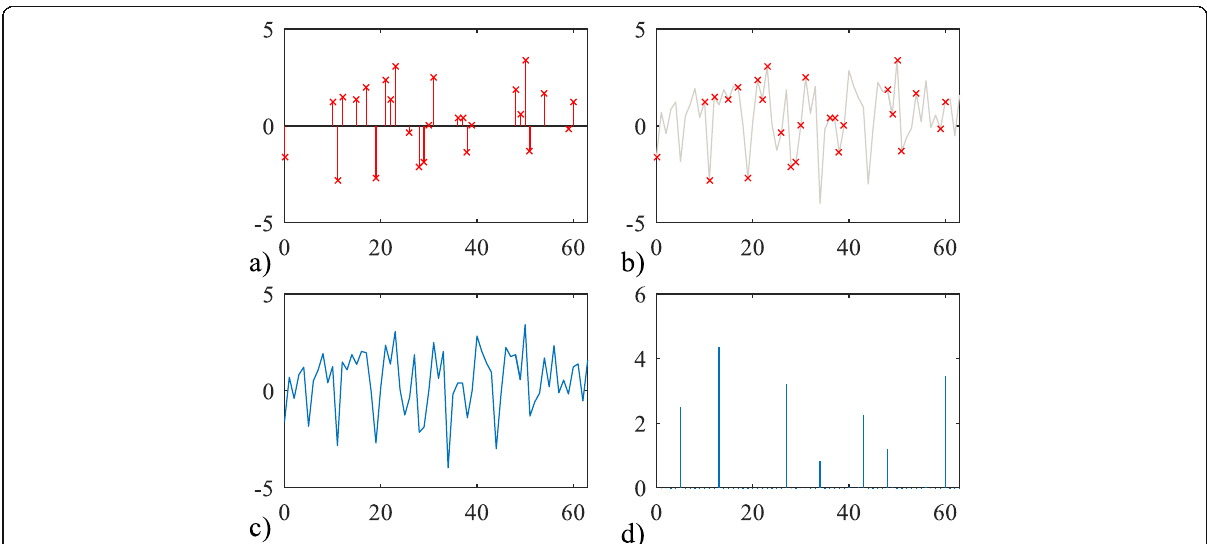
Fig. 10 a 26 (out of 64) available samples of synthetic signal, b original (full length) signal with marked available samples, c reconstructed (full length) signal, d Hermite transform of the reconstructed